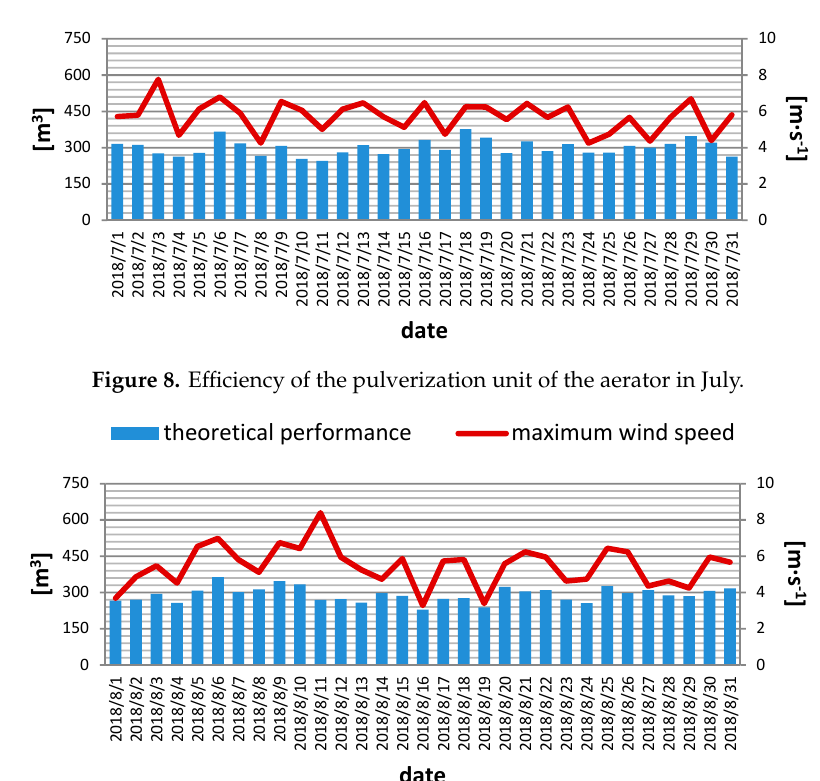
Figure 9. E ffi ciency of the pulverization unit of the aerator in Figure 9. Efficiency of the pulverization unit of the aerator in August.